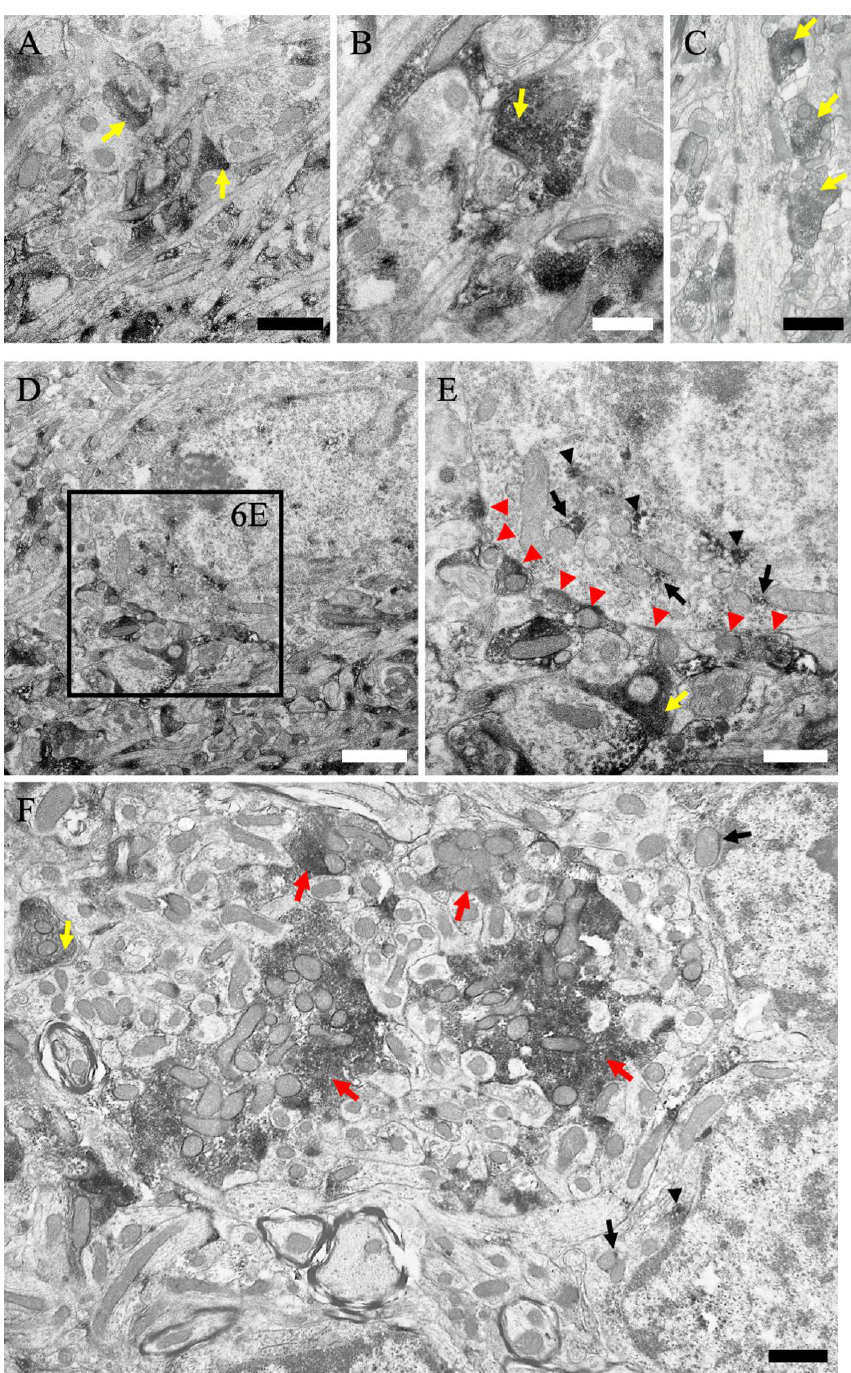
Figure 6. Immunoelectron microscopic views of the cerebellum are shown. ( A – C ) The neuropil in the molecular layer. ( D , E ) The Purkinje cell soma and the neuropil in the Purkinje cell layer; ( E ) shows a higher magnification view of ( D ). ( F ) The granular cell somata and neuropil in the granular cell layer. Black arrows indicate MGRN1 immunoreactivity near the mitochondria. Black arrowheads indicate MGRN1 immunoreactivity near the subcellular organelles; e.g., endoplasmic reticulum. Yellow arrows indicate MGRN1 immunoreactivity in the pre-synapses of axo-dendritic synapses. Red arrowheads indicate MGRN1 immunoreactivity in the pre-synapses of axo-somatic synapses. Red arrows indicate MGRN1 immunoreactivity in the cerebellar glomeruli. Scale bars in ( A ) and ( E ) = 1 μm; ( B , C , F ) = 500 nm; and ( D ) = 2 μm.